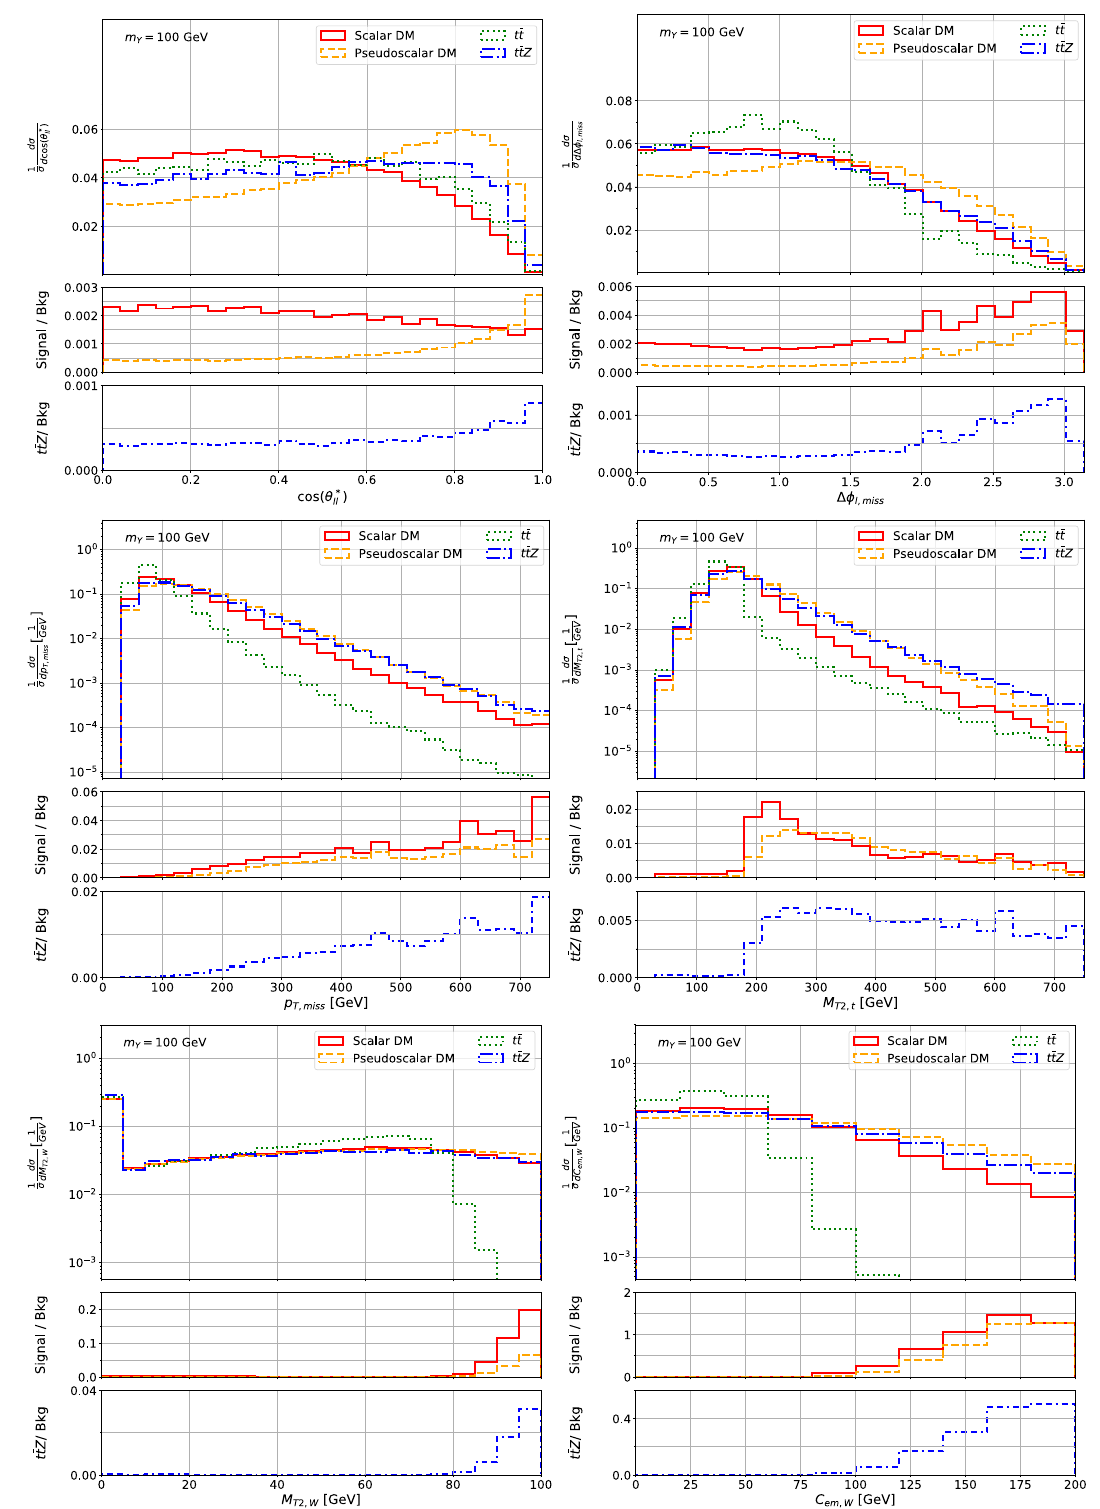
√ s = 13 TeV. In the central for the LHC with center of mass energy panels we show the signal-to-background ratio including the respective lepton flavour factors. The lower panels depict the fraction of the t ¯ tZ contribution to the total